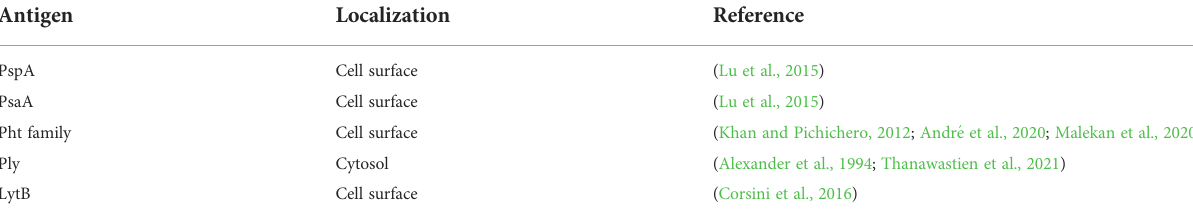
TABLE 1 Streptococcus pneumoniae